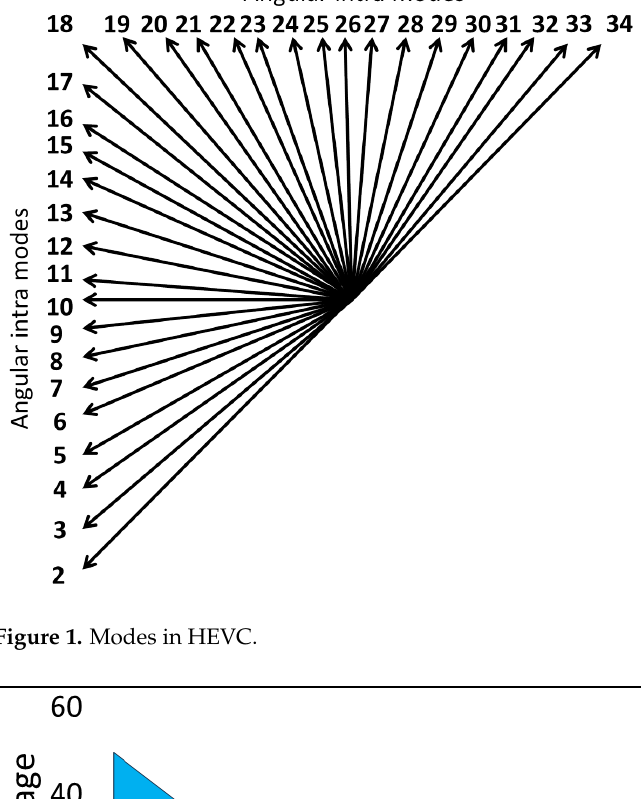
Figure 1. Modes in HEVC.